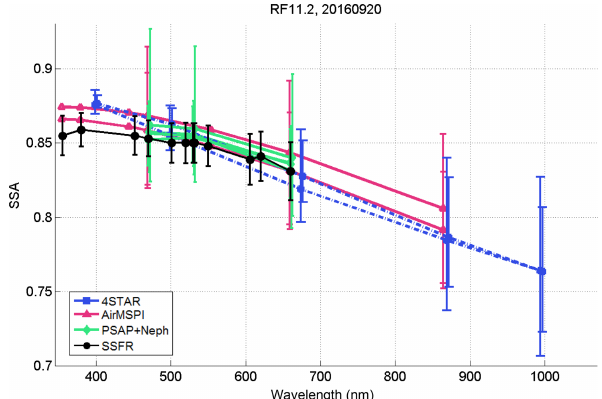
Figure 6. As in Fig. 4 but showing spectral SSA for the ORA- CLES instruments operating on 20 September 2016: 4STAR sky scan retrievals (blue squares); AirMSPI retrievals (pink triangles); SSFR square spiral (black circles); and profile-averaged extinction- weighted SSA from the PSAP + neph (green diamonds). This case was centered at approximately 16.7 ◦ S, 9 ◦ E, and sampled from 10:45 to 12:15UTC. Note that for clarity, AirMSPI uncertainties are only reported for the three wavelengths input into the polarized retrieval algorithm (Sect.